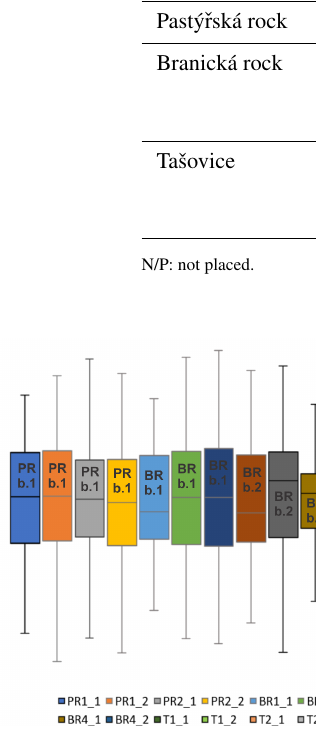
Figure 8. Boxplots of crackmeter position data. To compare the different positions of the measurements, the data were standardised. The boxplots show the max/min of the crackmeter position, median, first, and third quartile. The abbreviations inside the boxplots define the crackmeter locations. PR: Pastýˇrská rock, BR: Branická rock, T: Tašovice. Specific blocks are defined by numbers b.1–b.3. These correspond to the blocks displayed in Fig.